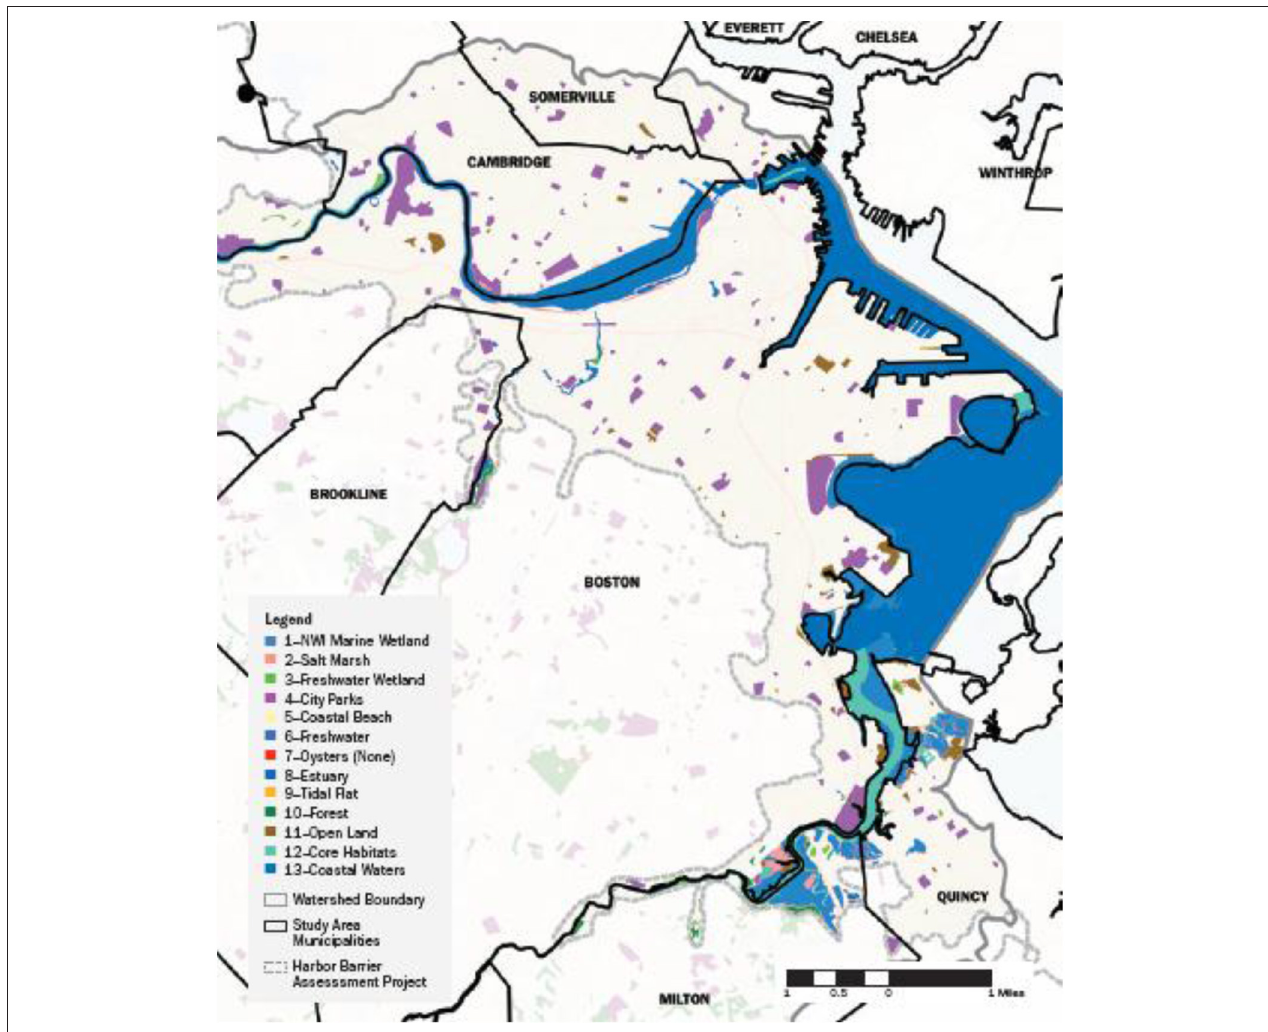
FIGURE 4 | Charles and Neponset Rivers